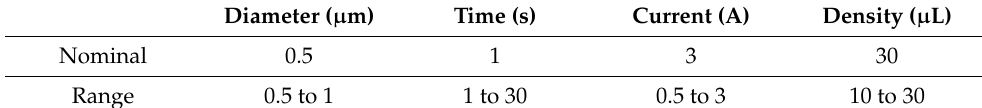
Table 5. Nominal values and the ranges of change in the effective parameters.